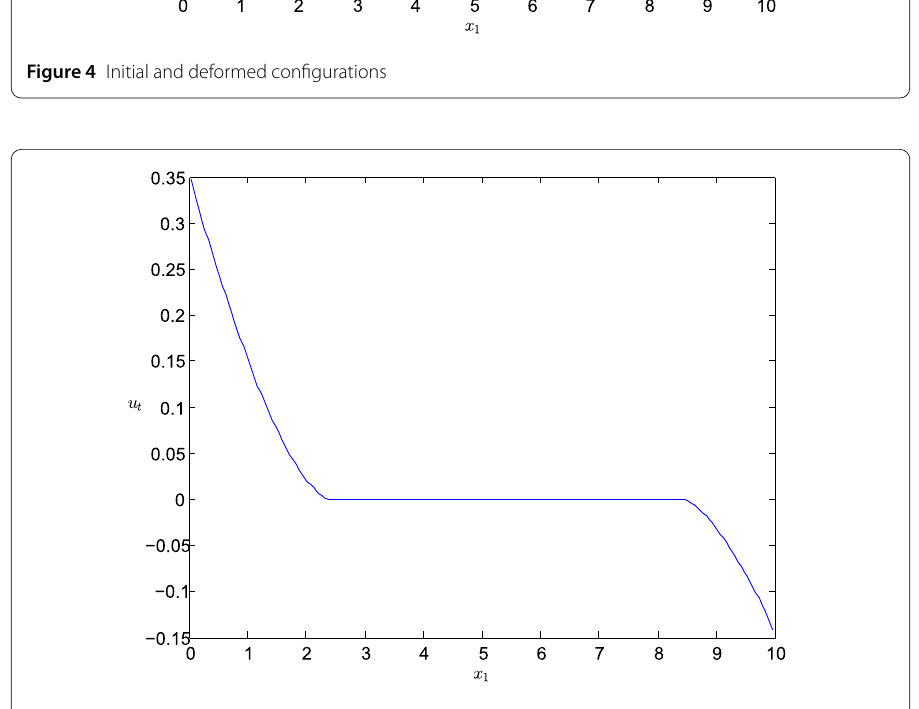
Figure 5 Tangential displacements on Γ